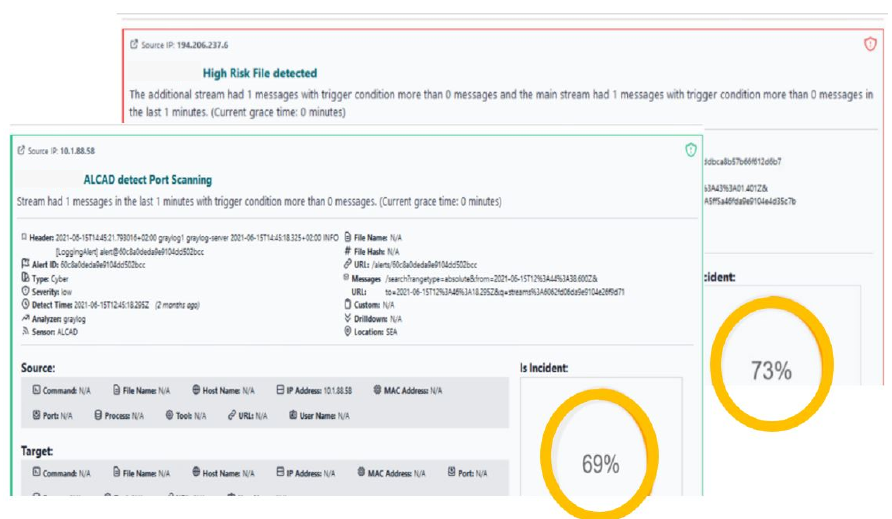
Figure 24. SMS-I Intelligent Dashboard: Malware Detection by Malware Analyser and Network Scan detection by ALCAD system (part of SATIE Toolkit)